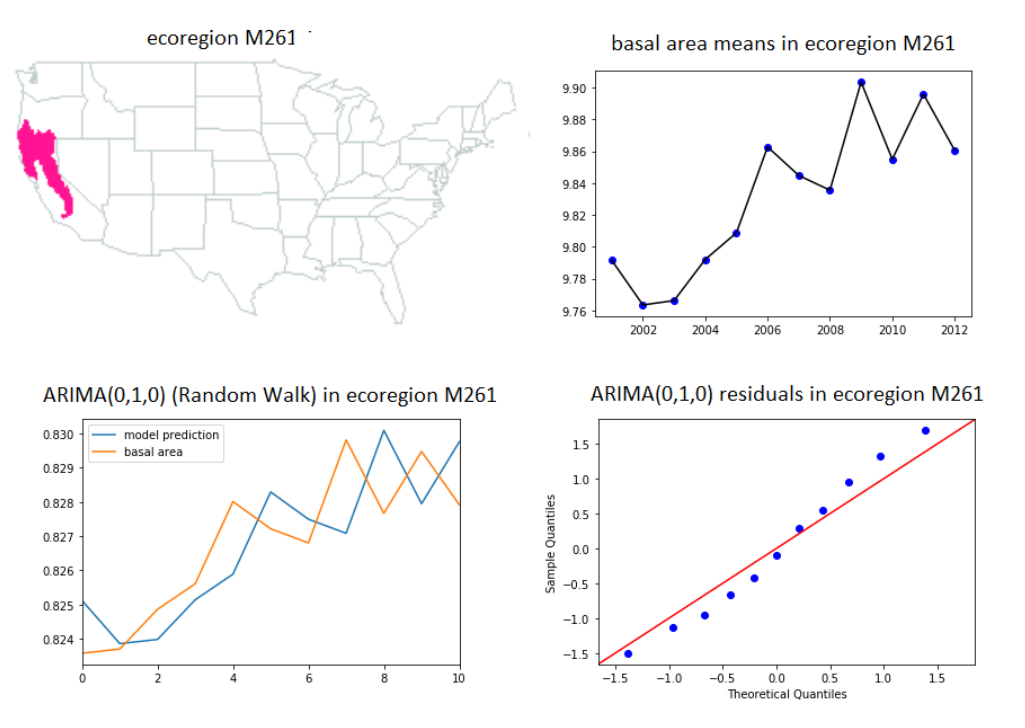
Figure A2. ARIMA (0,1,0) model results for basal area annual means in ecoregion M261 (Sierran Steppe Mixed Forest Coniferous